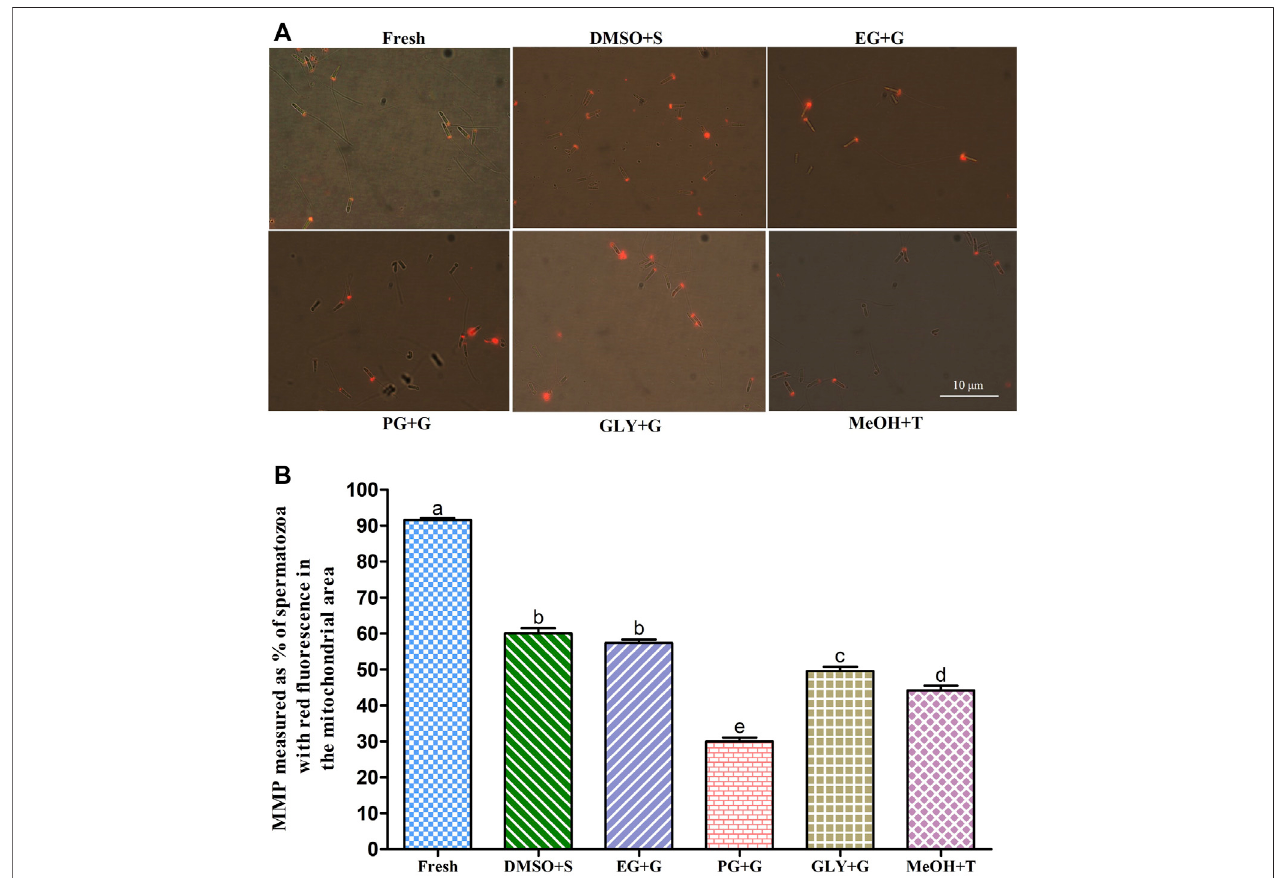
FIGURE4| Effectsofsaccharides(sucrose,glucose,andtrehalose)onthemitochondrialmembranepotential(MMP)ofpost-thawsperm. (A) JC-1-stainedimages of fresh and cryopreserved sperm. (B) MMP results of different types of post-thaw sperm. Results are presented as mean values ±standard deviation (n = 10). DMSO + S: 8% dimethyl sulfoxide (DMSO) combined with 3% sucrose (S), EG + G: 8% ethylene glycol (EG) combined with 1% glucose (G), PG + G: 6% propylene glycol (PG) combined with 2% glucose (G), GLY + G: 2% glycerol combined with 3% glucose (G), and MeOH + T: 2% methanol (MeOH) combined with 4% trehalose (T). Signi fi cantly different levels ( p < 0.05) are denoted by different